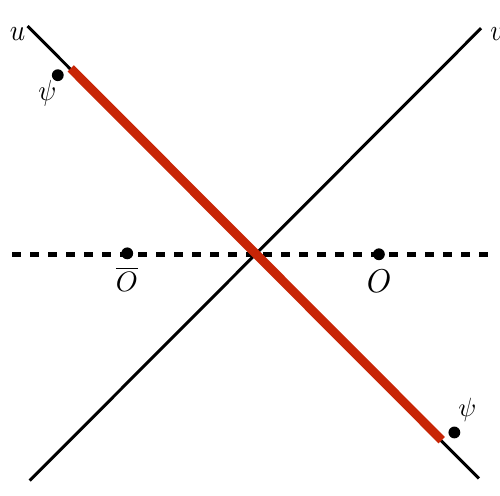
Figure 1 . Kinematics for the derivation of the ANEC. The leading correction to the OPE is the null energy integrated over the red line, which in the limit of large u takes the form This is then related to an expectation value by a Euclidean